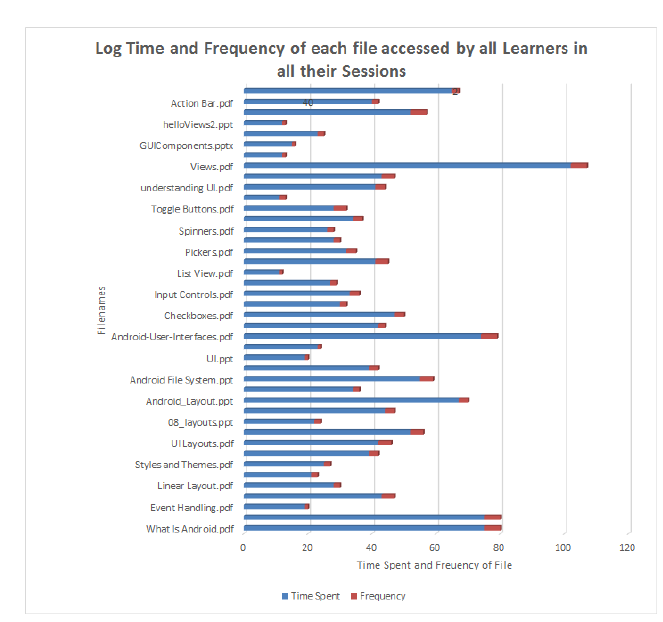
Figure 2. Frequency and Time Spent on Specific File by Learners